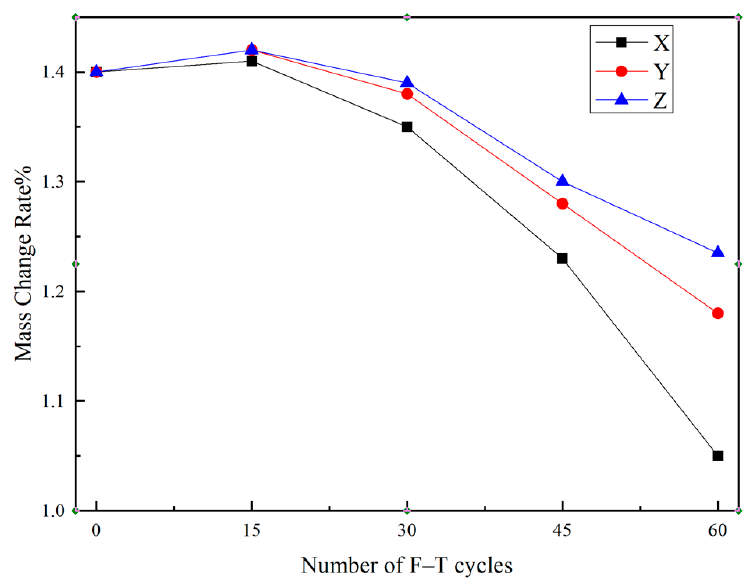
Figure 4. Mass change rate curve of three freeze–thaw cycle treatments.